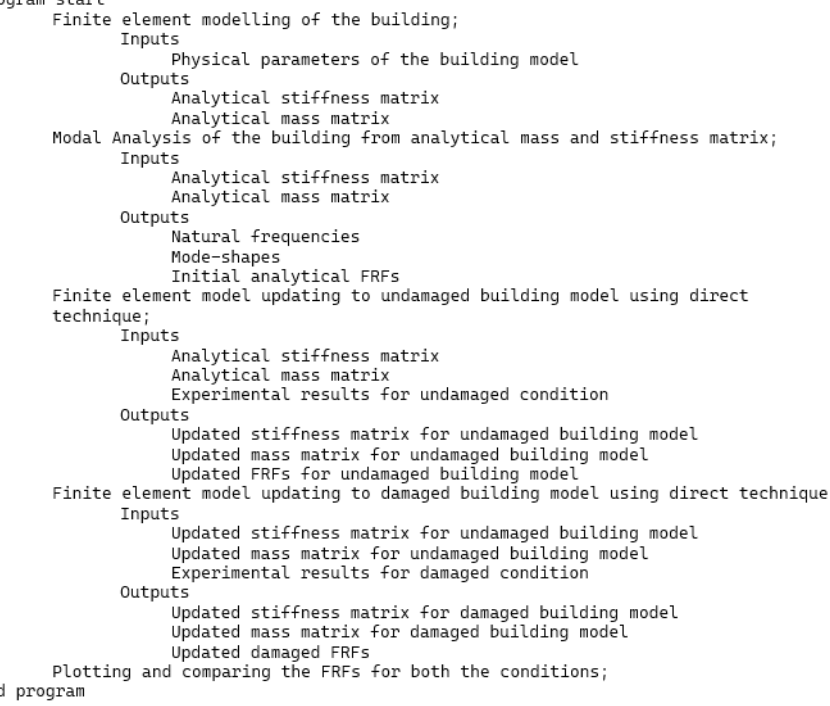
Figure 5. Pseudo code for extracting and plotting FRFs.